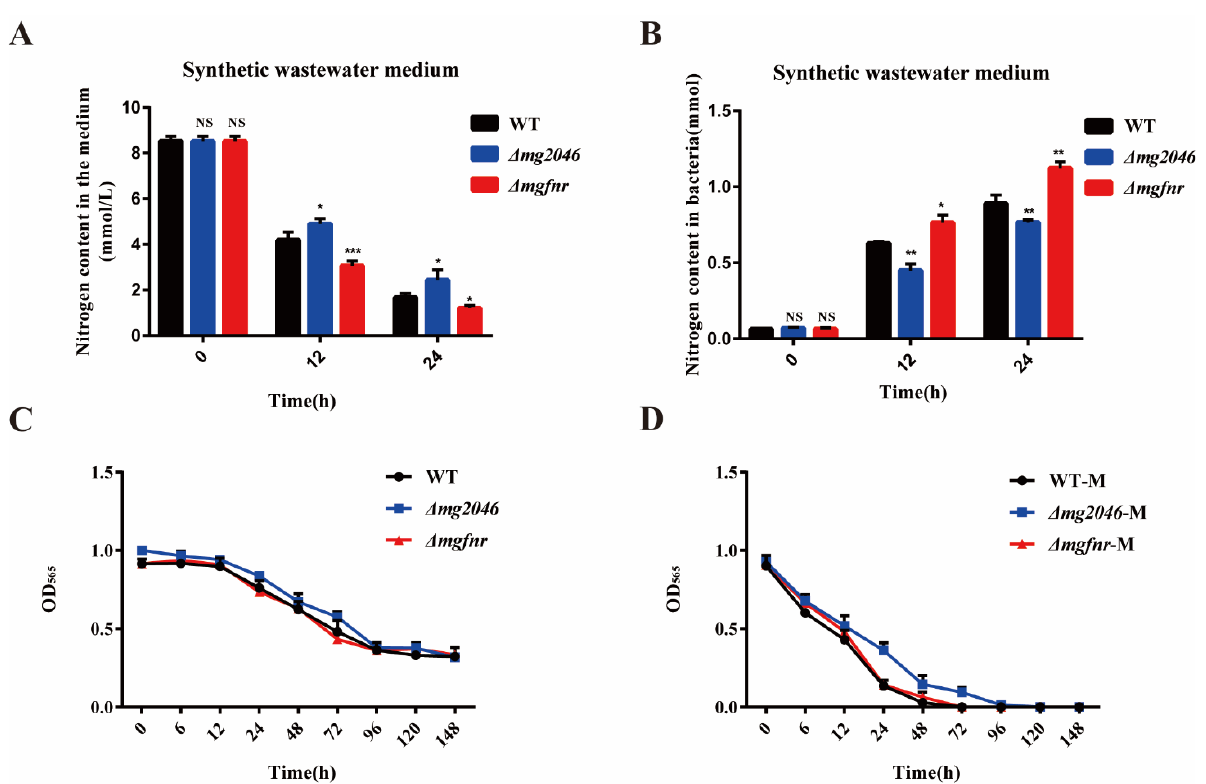
Figure 6. Total nitrogen content of media and bacteria in synthetic wastewater medium for WT, Δmg2046 , and Δmgfnr ( A , B ), and OD 565 curves (C, D). ( A ) Media. ( B ) Bacteria. ( C ) OD 565 curve during natural sedimentation. ( D ) OD 565 curve during magnetic adsorption sedimentation. NS: no significant difference ( t -test). * p < 0.05; ** p < 0.01; *** p < 0.001. Error bar: SD from three replicate experiments.